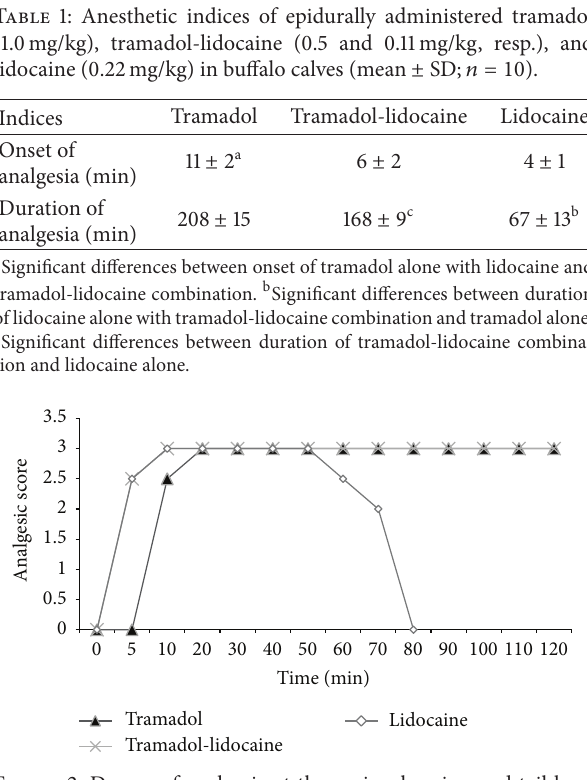
Figure 2: Degree of analgesia at the perineal region and tail base after epidural analgesia of tramadol, tramadol-lidocaine combina- tion, and lidocaine in buffalo calves.